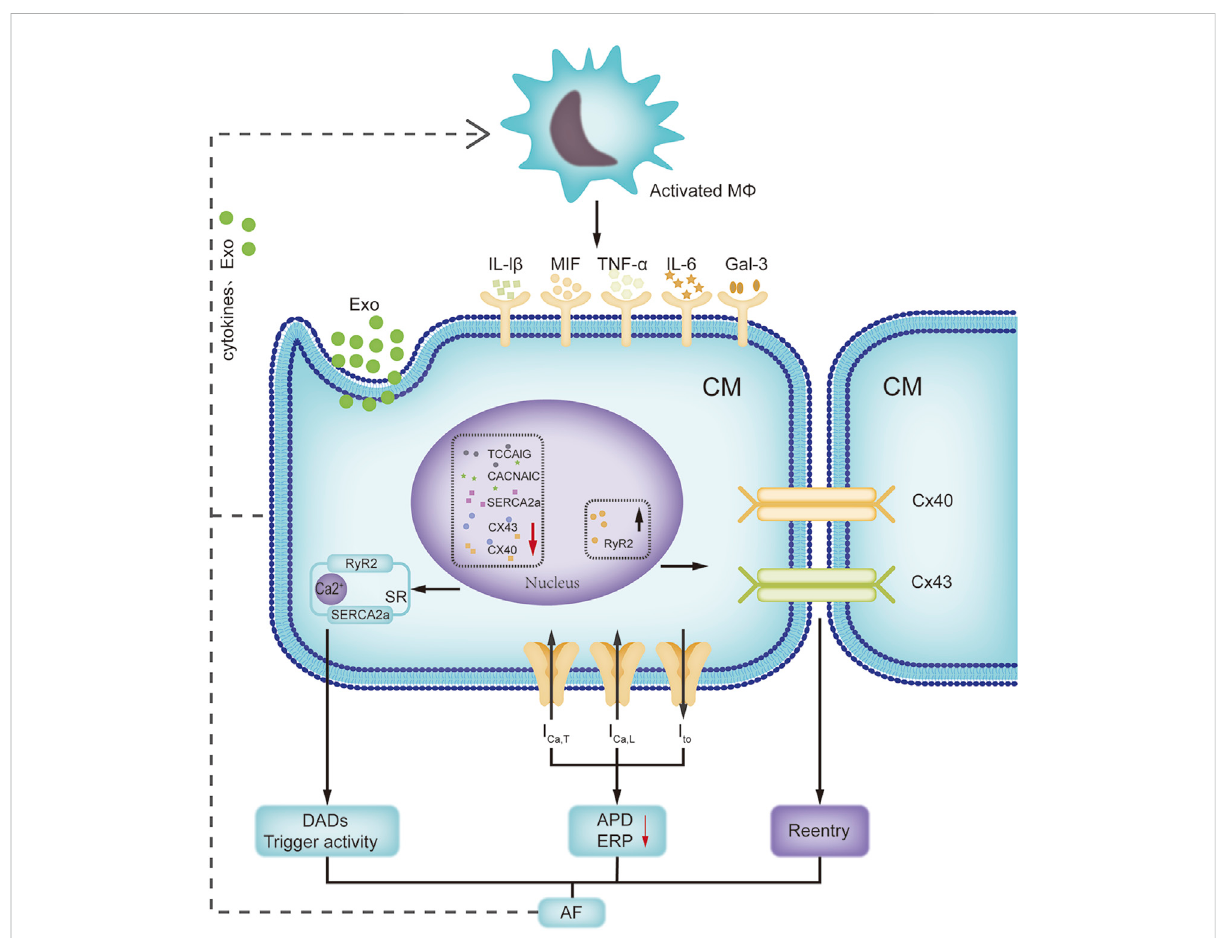
FIGURE 2 Interactions of immune remodeling and electrical remodeling. This fi gure focuses on the interactions between activated macrophage and cardiomyocyte. Activated macrophages can release cytokines and exosomes to affect the expression of ion channels and connexins in cardiomyocytes. Meanwhile, pacing cardiomyocytes can promote the macrophage activation. Abbreviations: APD, action potential duration; CACNA1C, L-type calcium channel α 1C subunit; CM, cardiomyocyte; Cx 40, connexin 40; DAD, delayed after-depolarization; ERP, effective refractory period; Exo,exosomes;Gal-3, galectin3;I Ca-T ,Ttypecalciumchannelcurrent;I to ,transient outward potassiumcurrent;IL-6, interleukin- 6; M φ , macrophage; MIF, macrophage migration inhibitory factor; RyR2, ryanodine receptor 2; SR, sarcoplasmic reticulum; SERCA2a,